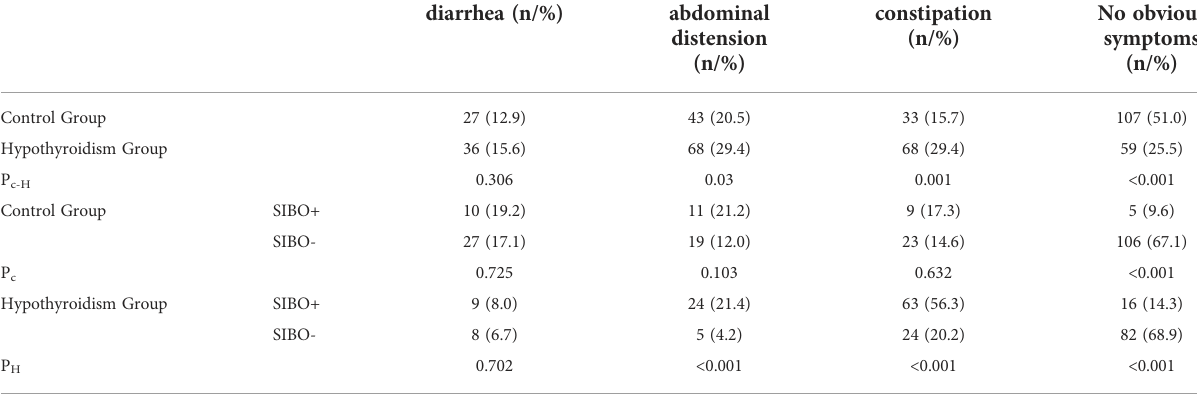
TABLE 2 Comparison of gastrointestinal symptoms between the hypothyroidism group and the control group during pregnancy.